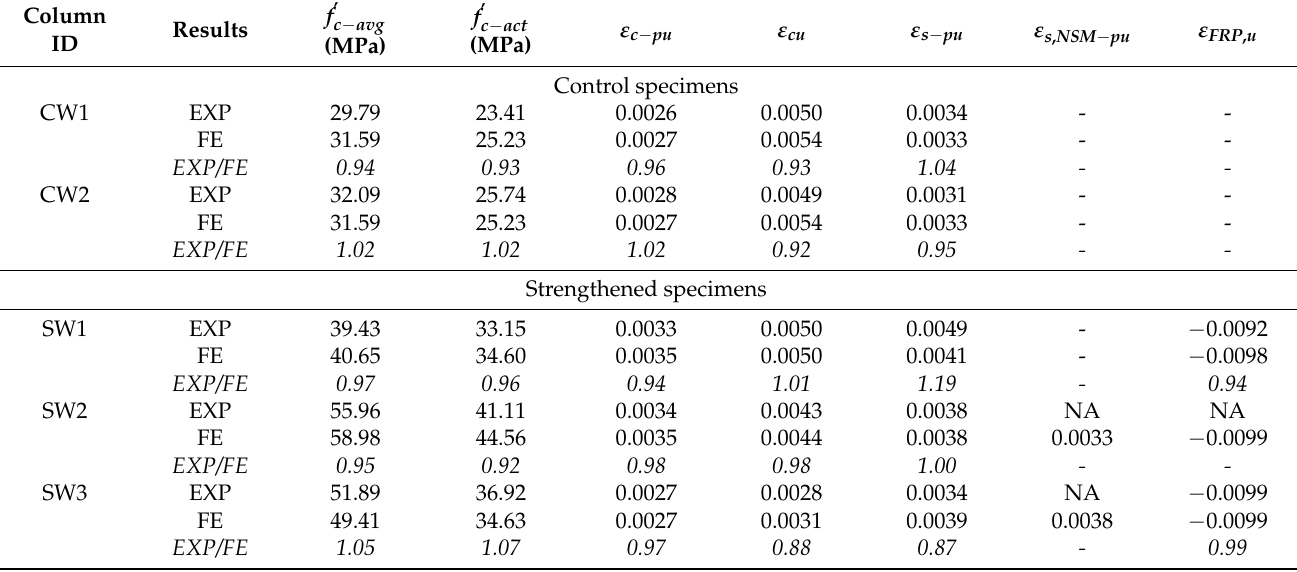
Table 4. Comparison of experimental and FE results of stress-strain relationship for test columns